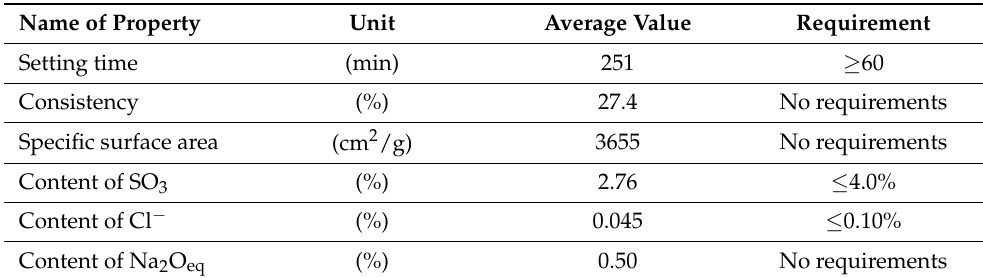
Table 2. The chemical and physical properties of the Portland cement CEM I 42.5 R (based on the information provided in